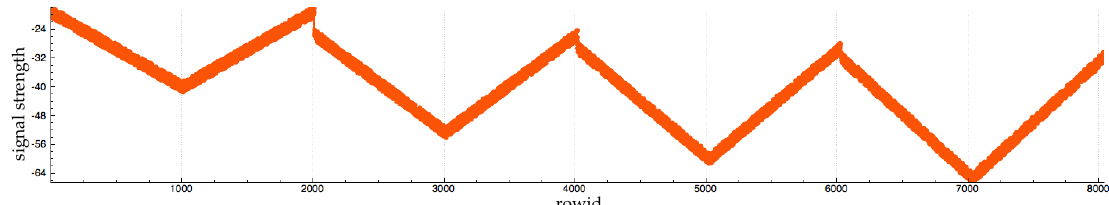
Figure 4. Evolution of RFID signal strength. In rows [0–2000], the tag is approximately 1 m away from the antenna. In rows [2000–4000], the tag is approximately 4 m away from the antenna. In rows [4000–6000], the tag is approximately 10 m away from the antenna. In rows [6000–8000], the tag is approximately 10 m away from the antenna.